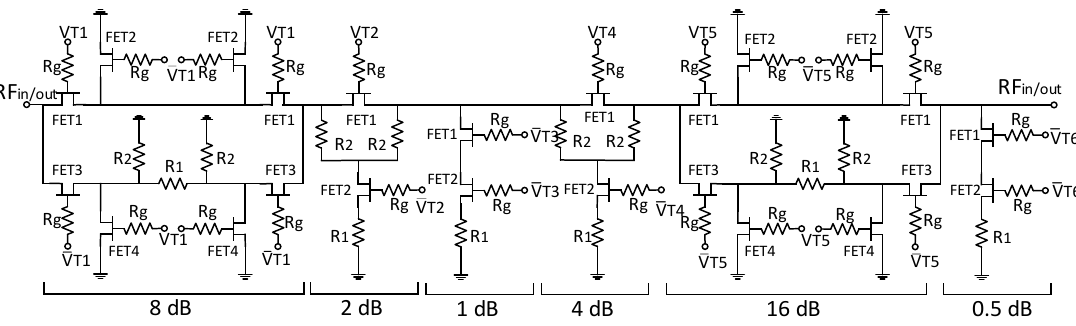
Figure 3. The schematic of the 6-bit digital attenuator.